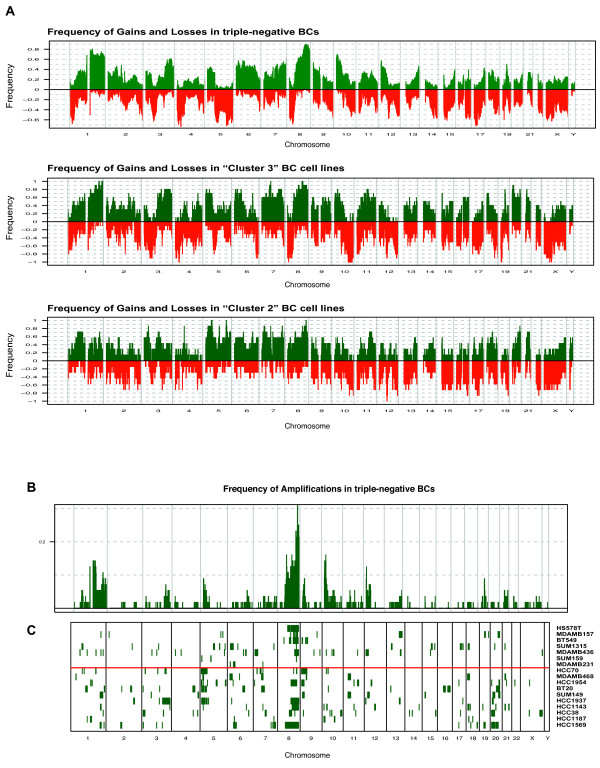
Genomic alteration of triple-negative BCs and ER-negative BC cell lines. (A) Genomic profiles of 56 triple-negative BCs were obtained from Turner [31]. The proportion of samples for each group (triple-negative BCs, ”Cluster 2 and 3” BC cell lines) is plotted in which each genomic area is gained (green) or lost (red) according to their genomic position. (B) The frequency of triple-negative BCs in which the smoothed log2ratios of each BAC clone above 0.45 is plotted (y-axis) according to its genomic location (x-axis). (C) Using the same criteria for the aCGH data of BC cell lines, amplified BAC clones for each BC cell line (row) are represented as green lines along the genome. The separation between ”Cluster 2 and 3” BC cell lines are indicated with a red line.